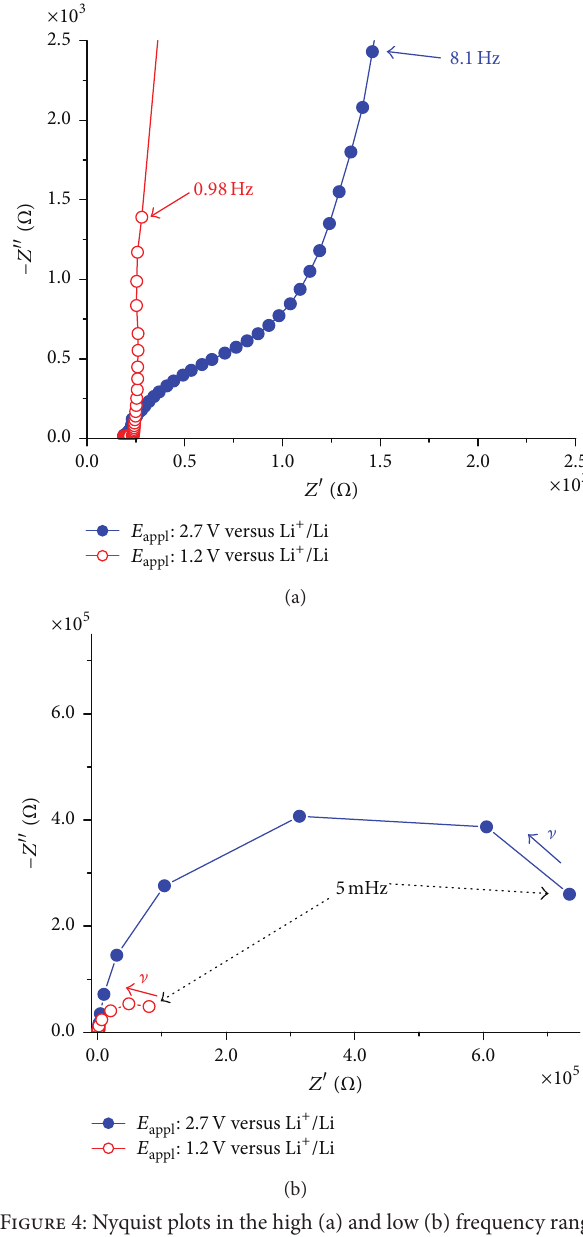
Figure 4: Nyquist plots in the high (a) and low (b) frequency range for lithiated ITO at 2.7 V versus Li + /Li and 1.2 V versus Li + /Li after stabilization of the voltammogram (see Figure 1).